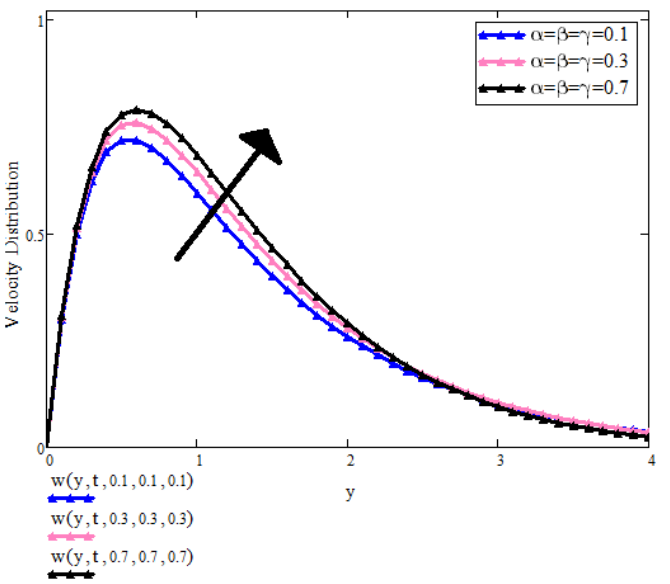
Figure 5. u ( y , t ) with α , β , γ when t = 1, a = 0.1, λ = 0.5, λ 2 = 0.9, Pr = 6.2, β 1 = 0.9, φ 1 = φ 2 = φ 3 =